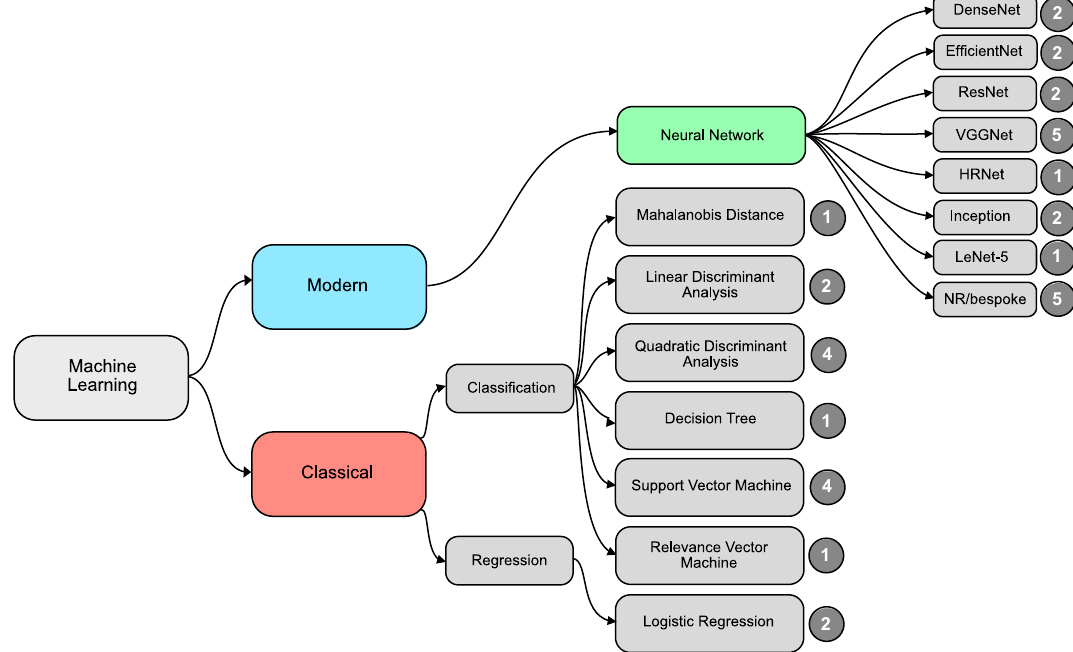
Figure 4. Summary of best performing machine learning algorithms adopted by identified studies. The numbers represent the number of studies who reported best outcomes with the associated model. VGG visual geometry group, HR high resolution, NR not